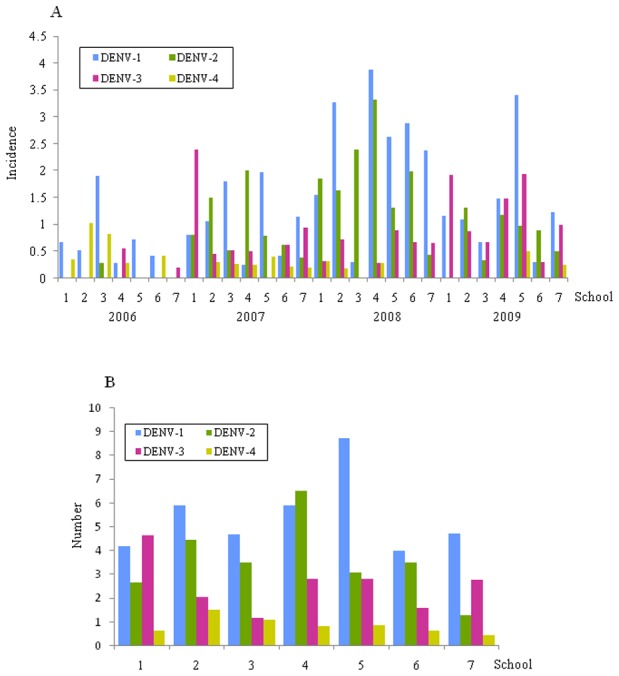
Serotype incidence.(A) Shown is the serotype incidence by school in each year. (B) Shown is the serotype incidence by school in all years.